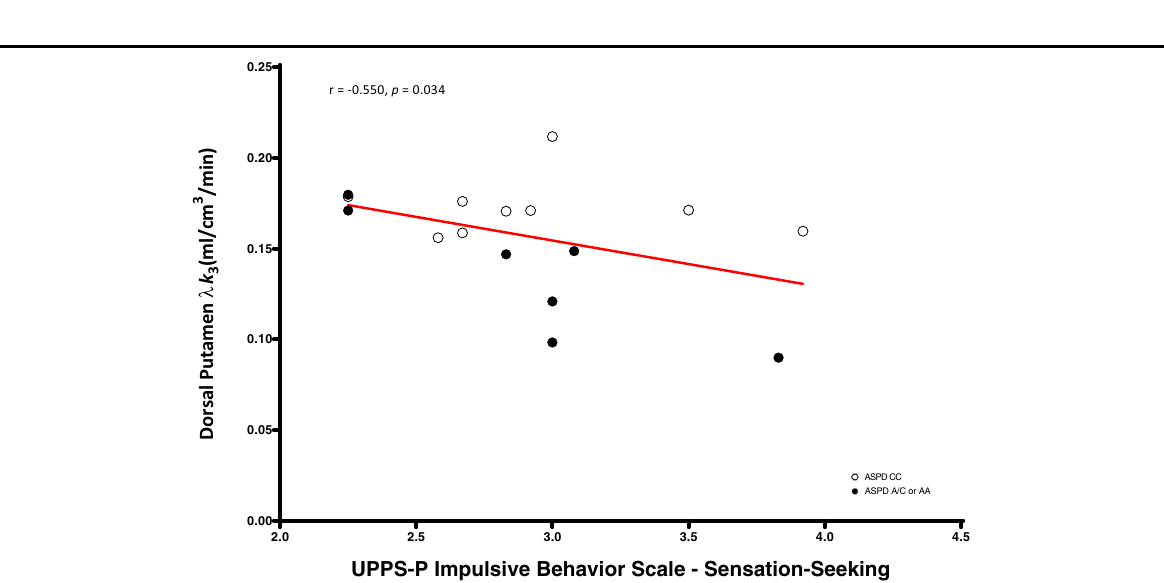
Fig. 4 Dorsal putamen fatty acid amide hydrolase λ k 3 is negatively correlated with UPPS-P Impulsive Behavior Scale – sensation-seeking in antisocial personality disorder. After controlling for genotype, antisocial personality disorder participants with lower dorsal putamen fatty acid amide hydrolase endorsed greater sensation-seeking